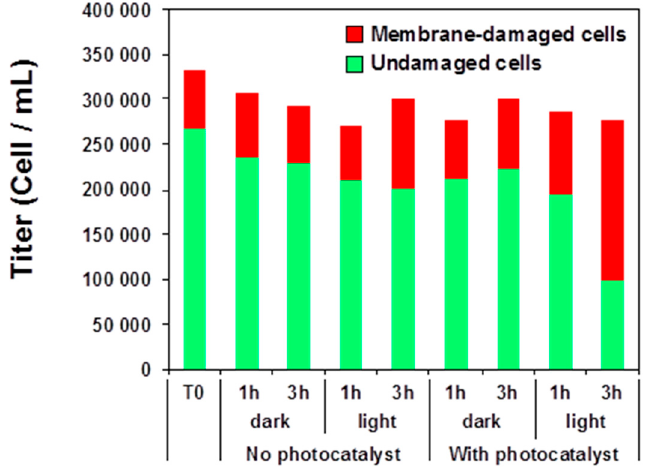
Figure 6. Enumeration of undamaged (SYBR Green II staining) and membrane-altered (propidium iodide (PI) staining) of bacteria by epifluorescence microscopy.